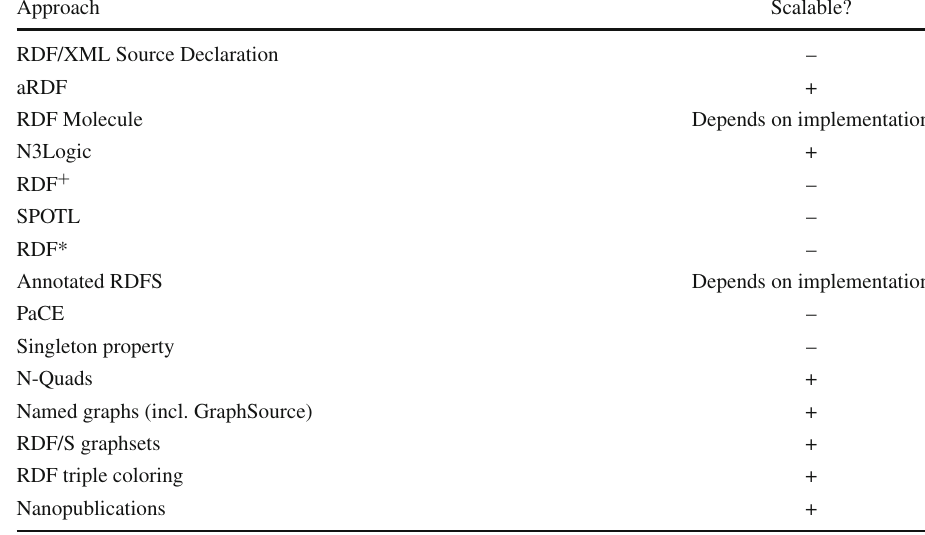
Table 8 Not all reification alternatives are